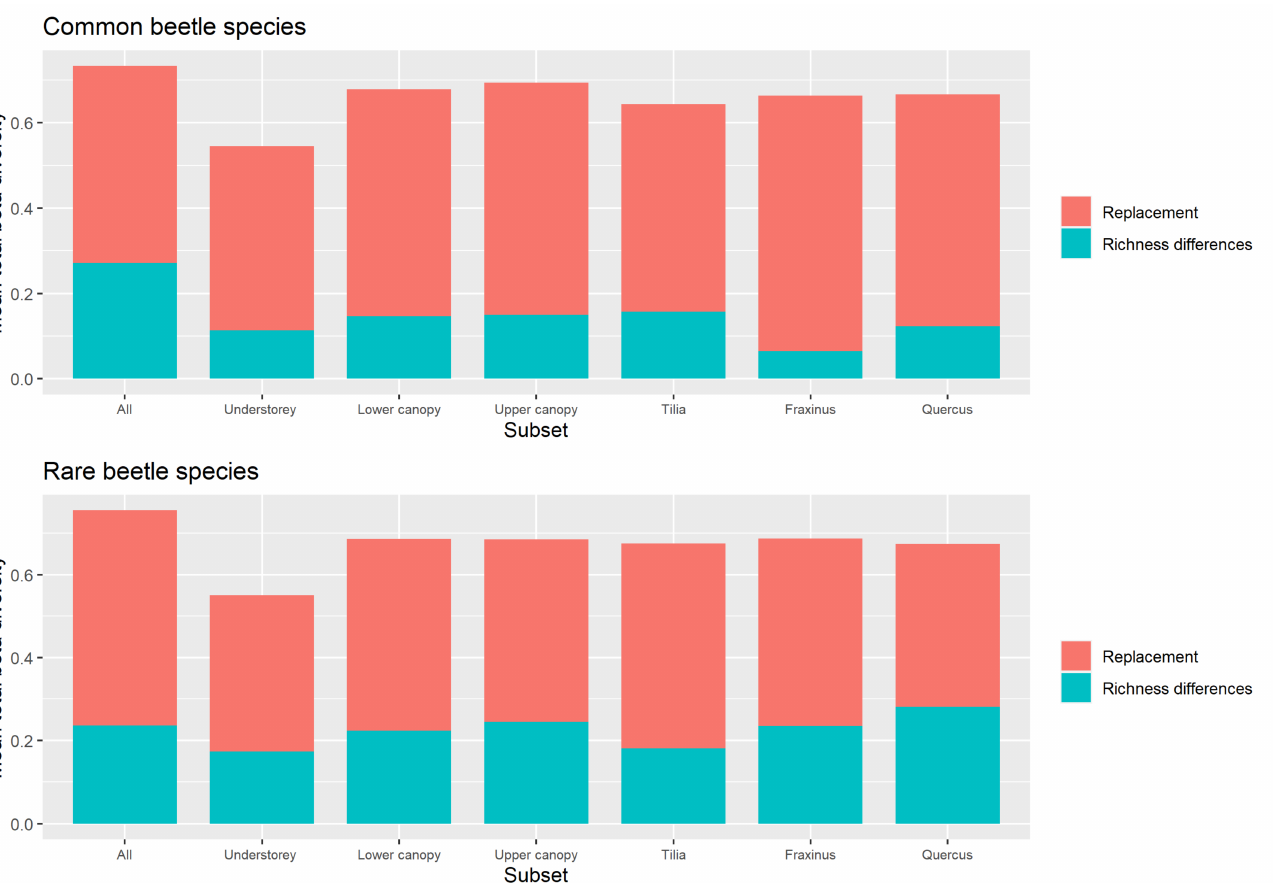
Figure A1. The contribution of replacement and richness differences to the total beta diversity for all studied strata and tree